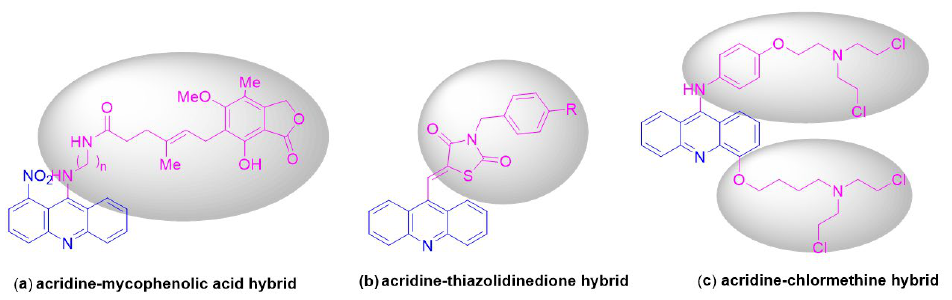
Figure 1. Structures of some hybrid molecules ( a – c ) at the 9-position of the acridine skeleton.